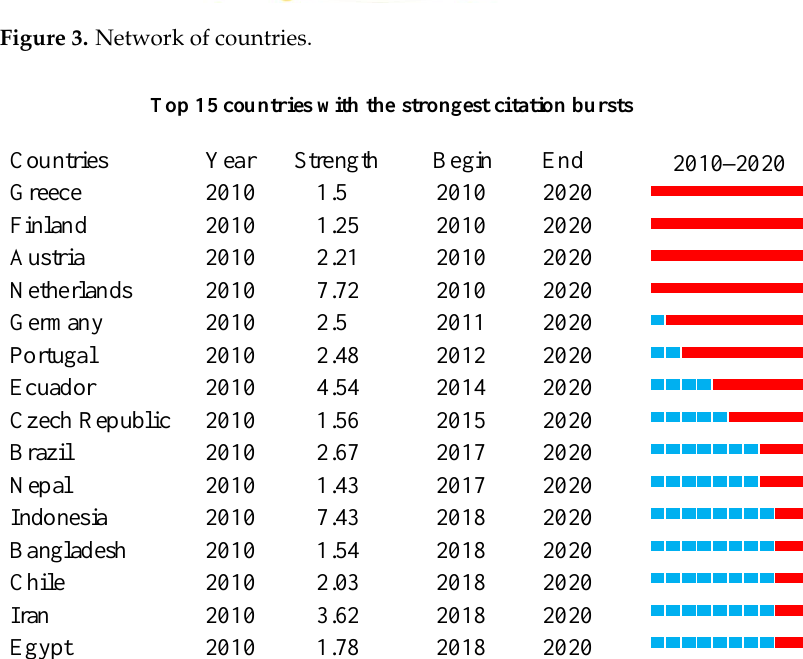
Figure 3. Network of countries.